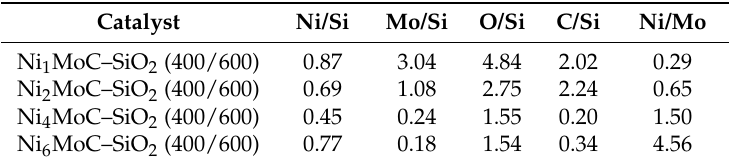
Table 7. XPS data and atomic ratio of elements on the surface of the calcined and reduced Ni x MoC–SiO 2 (400/600) catalysts.